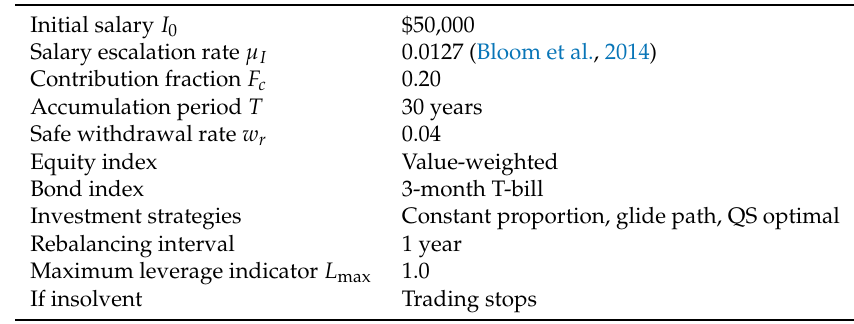
Table 2. Data for base case scenario. Cash is injected into the portfolio at times t = 0,1, . . . ,29. Market parameters for the equity and bond indexes are provided in Table